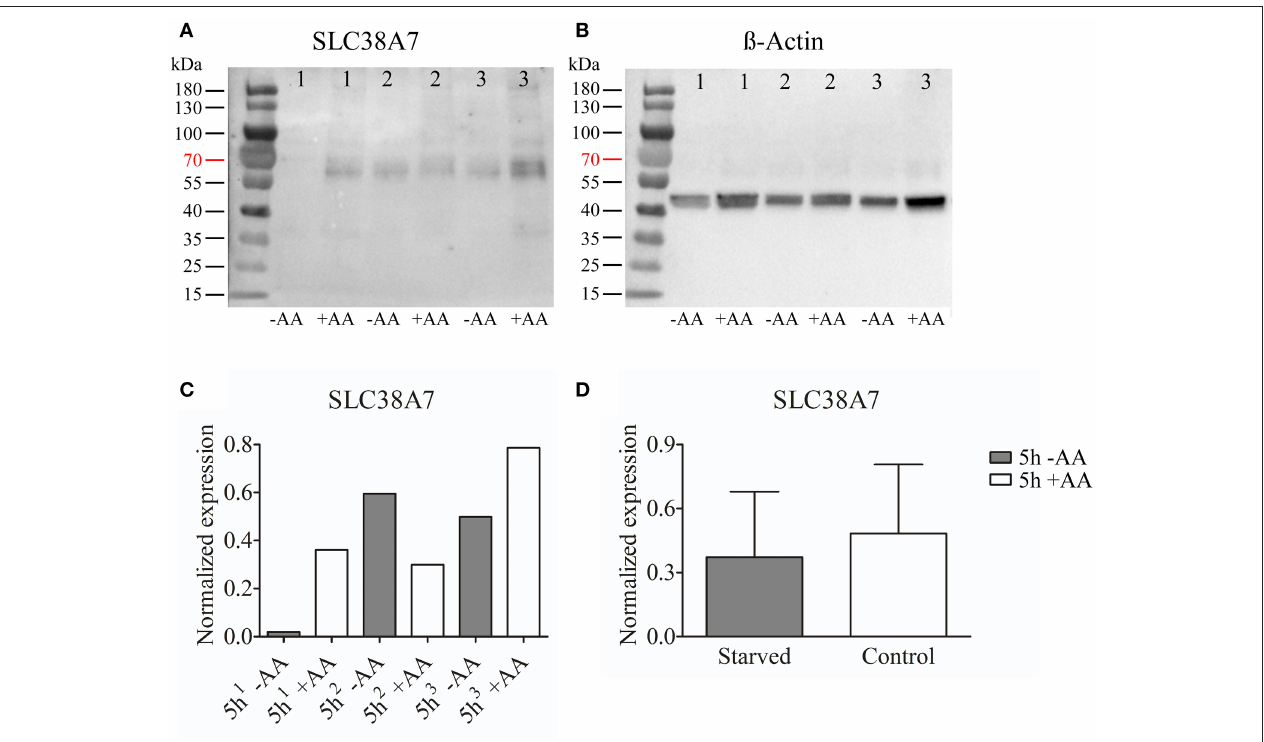
FIGURE 2 | Western blot analysis of SLC38A7 protein expression in the immortalized hypothalamic cell line N25/2 after complete starvation at 5h. (A) The blot (developed for 18.4s) displays the protein expression of SLC38A7 in three replicates (1, 2, 3) from each treatment group. The predicted size of the mouse SLC38A7 protein is 49.9 kDA (463 amino acids, NP_766346) and a band with approximately size of 62 kDa was detected. (B) The blot (developed for 3.1s) displays the protein expression of β -actin in each sample which was used for normalization of protein expression in each sample. (C) The graph illustrates the normalized protein expression of SLC38A7 in the starved cells compared with the amino acid treated controls for each replicate. (D) The graph represents the normalized protein expression of all replicates in each group (mean value of protein expression ± SD). An unpaired t -test was performed between the protein expression in starved cells and controls. No difference ( p = 0.6886) was detected on protein level for SLC38A7.